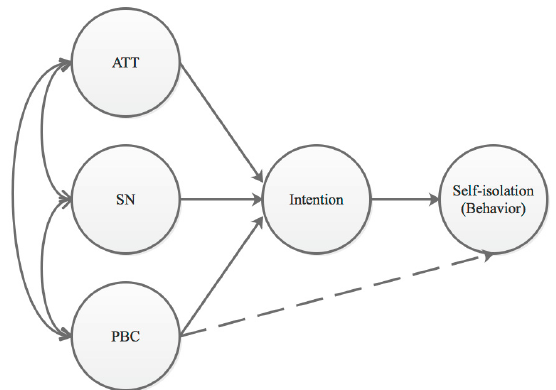
Figure 1. Conceptual Model. ATT, attitudes toward the behavior; SN, subjective norms with respect to the behavior; PBC, perceived control over the behavior.